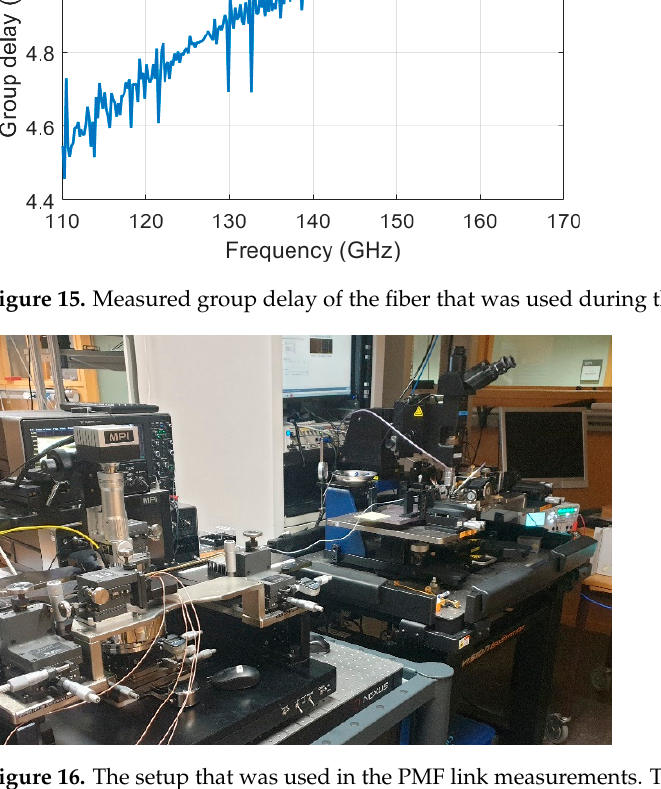
Figure 16. The setup that was used in the PMF link measurements. The fiber can be seen connecting one circuit on one probe station to the other one on the other probe station.